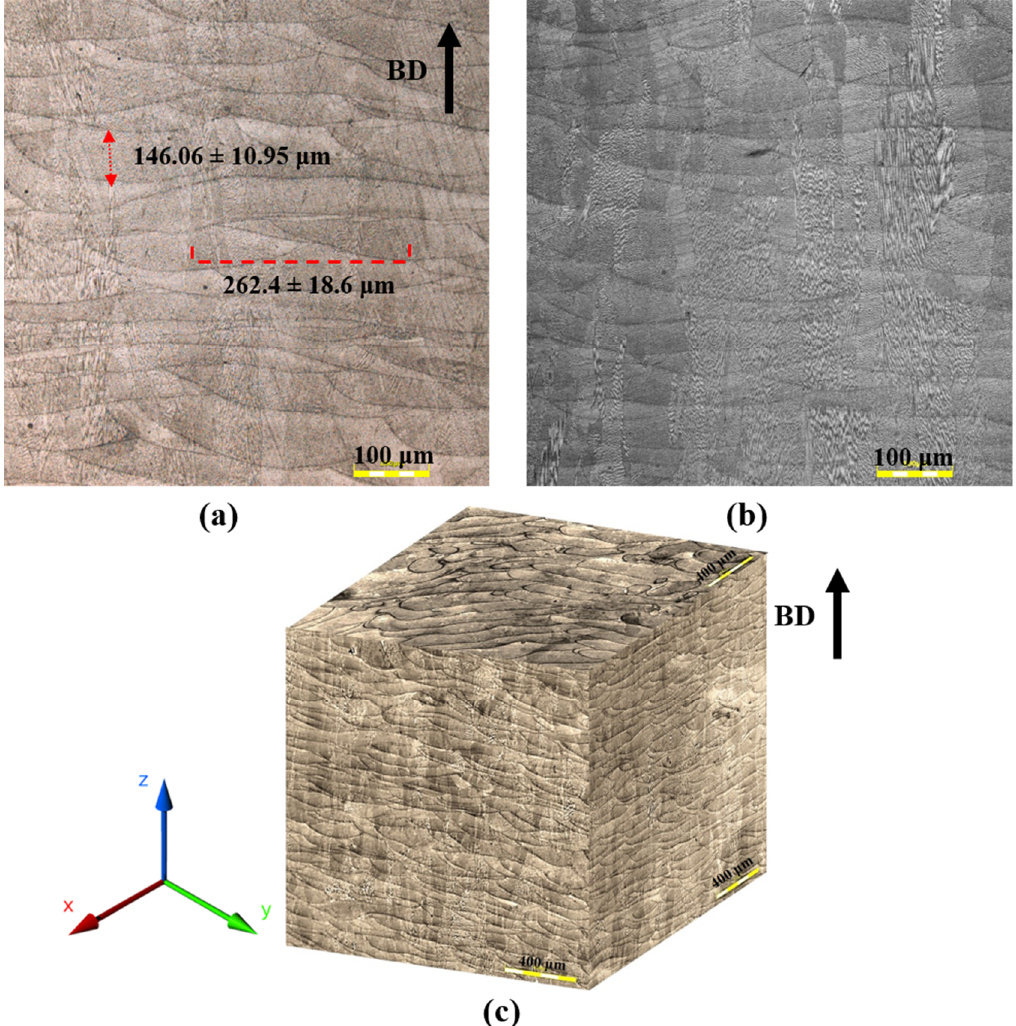
Figure 3. OM of as-Fabricated SLM-IN718 along the building direction (Z): ( a ) measured width and depth of a melt pool; ( b ) wide columnar grains elongated in the building direction; ( c ) 3D-reconstruction of cross-sectioned & polished planes of a SLM specimen.